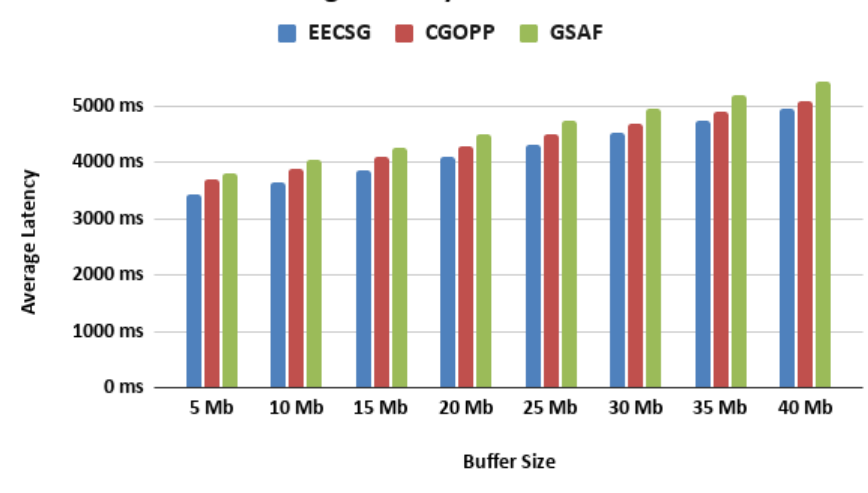
Figure 7. Average latency vs. buffer